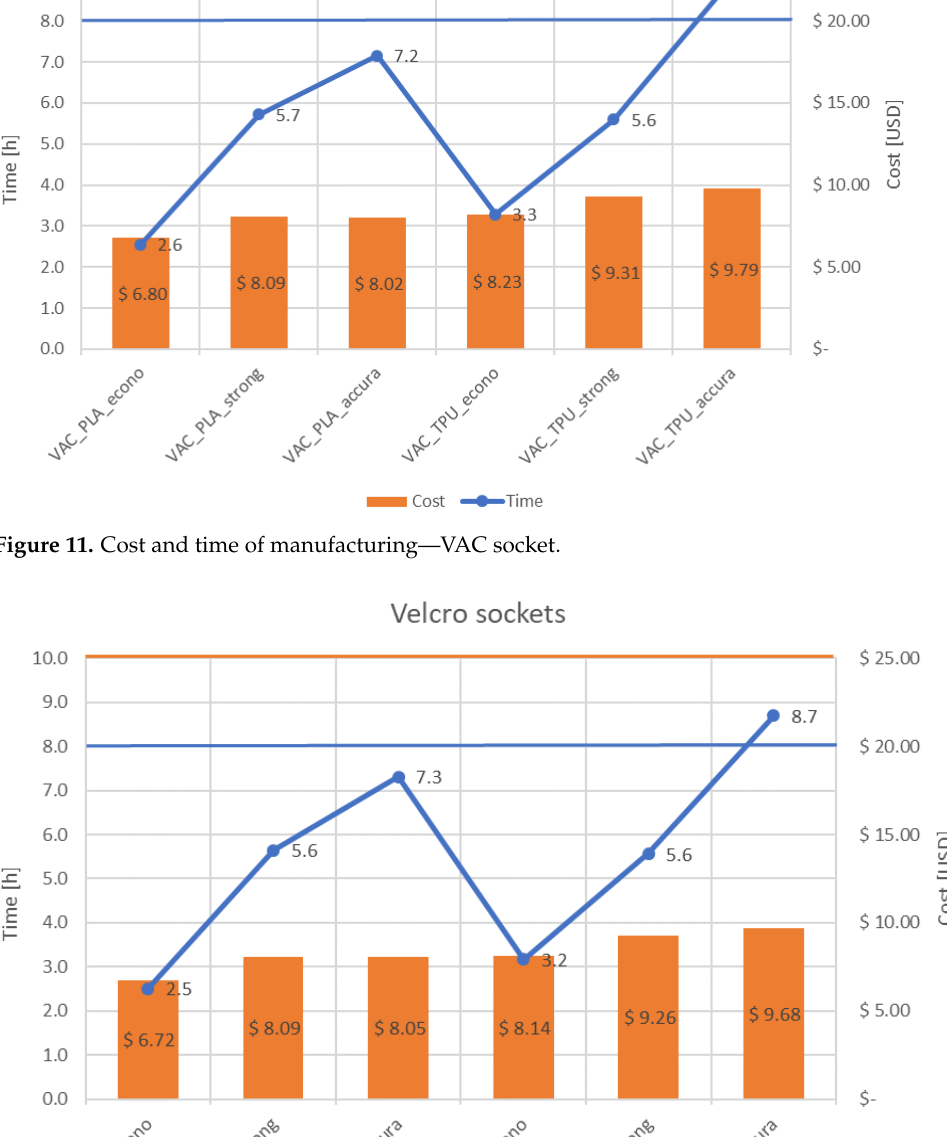
Figure 12. Cost and time of manufacturing — VEL socket.